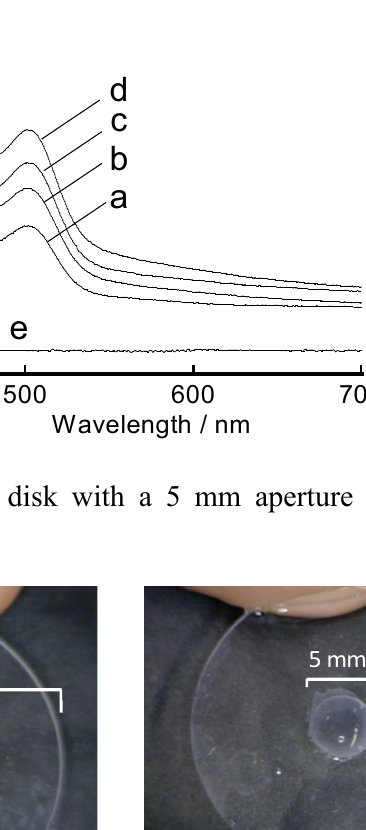
Figure 2. Absorption spectra of layer-by-layer (LbL) films composed of Fluorescein-modified-poly(allylamine hydrochloride) (F-PAH) and poly(styrene sulfonate) (PSS). The number of (F-PAH-PSS) bilayers: ( a ) 3; ( b ) 5; ( c ) 7; ( d ) 10; and ( e ) 0 (film-free glass disk).